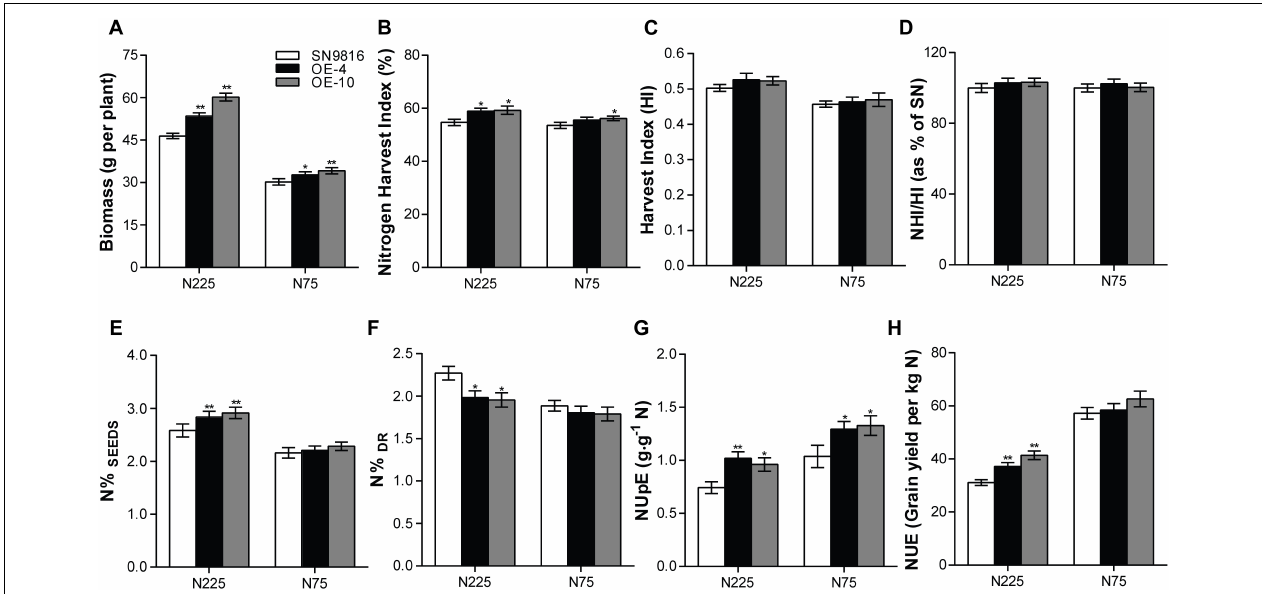
FIGURE 4 | Evaluation of biomass, NUpE, and NUE in transgenic rice. (A) Biomass accumulation as measured by dry weight of the whole plant, (B) Nitrogen harvest index (NHI), (C) Harvest index (HI), (D) the ration of NHI/HI, (E) N concentration in seeds (N% SEEDs ) and (F) in dry remains (N% Dr ), (G) Nitrogen uptake efficiency (NUpE) and (H) nitrogen use efficiency (NUE) in SN9816 and transgenic lines (OE-4 and OE-10) under N225 or N75 conditions. Values are means ± SD of one representative biological replicate ( n = 12) out of three, ∗ P < 0.05, ∗∗ P < 0.01 ( t